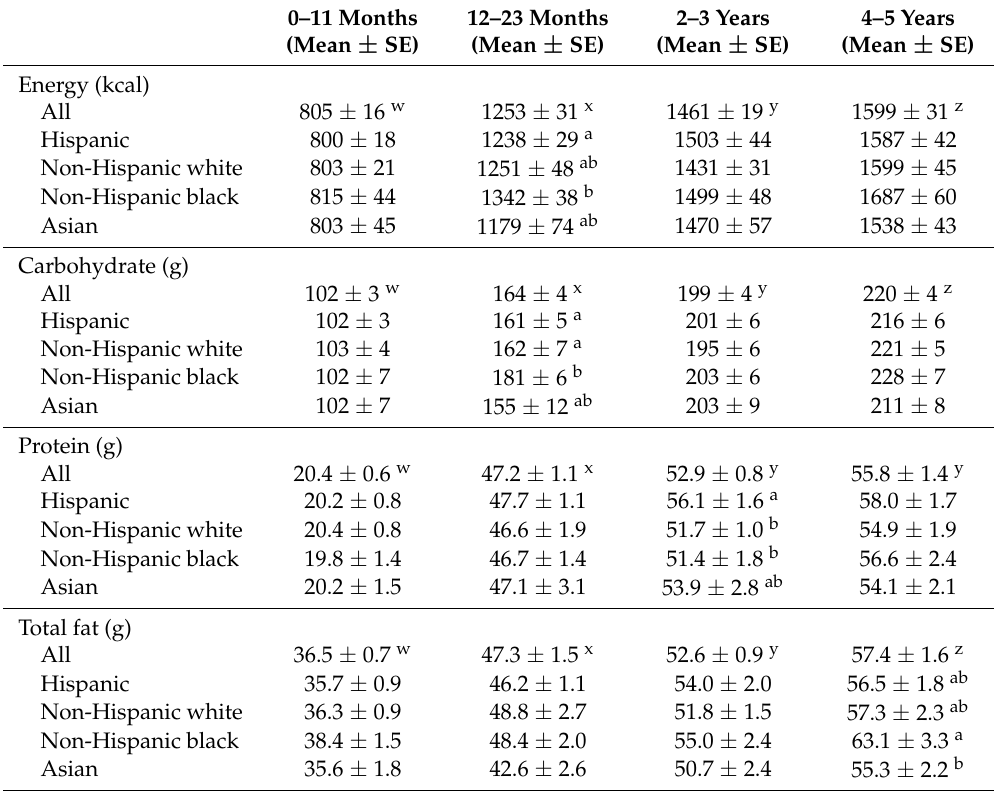
Table 5. Usual intake of total energy and macronutrient intake in children by age and ethnicity, NHANES